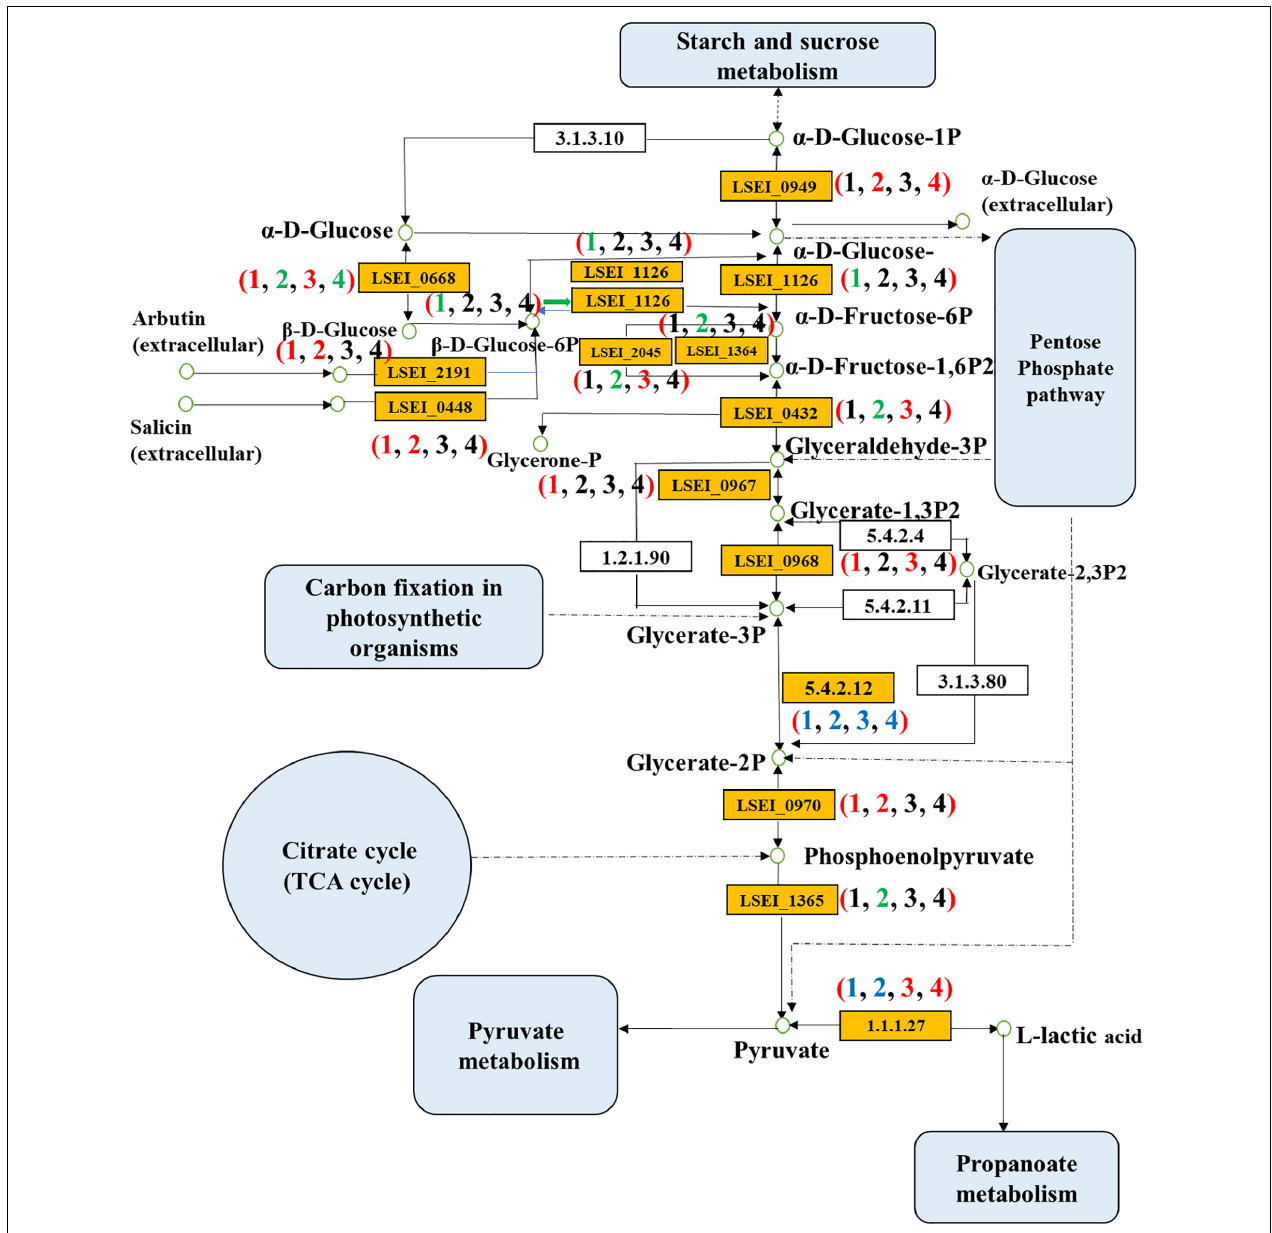
FIGURE 5 | Differentially expressed genes of glycolysis pathway in four pairwise comparisons (Numbers in brackets 1, 2, 3, and 4 refer to the L3 vs L1 days, LY3 vs LY1 days, LY1 vs L1 days, and LY3 vs L3 days, respectively. L1 day refers to single inoculation with L. paracasei on the first day, L3 day refers to single inoculation with L. paracasei on the third day, LY1 day refers to mix inoculation with L. paracasei and K. marxianus on the first day, LY3 day refers to mix inoculation with L. paracasei and K. marxianus on the third day. The colors red, green, blue, and black represent the up-regulated gene, down-regulated gene, both of up-regulated gene and down-regulated gene, and no change gene,